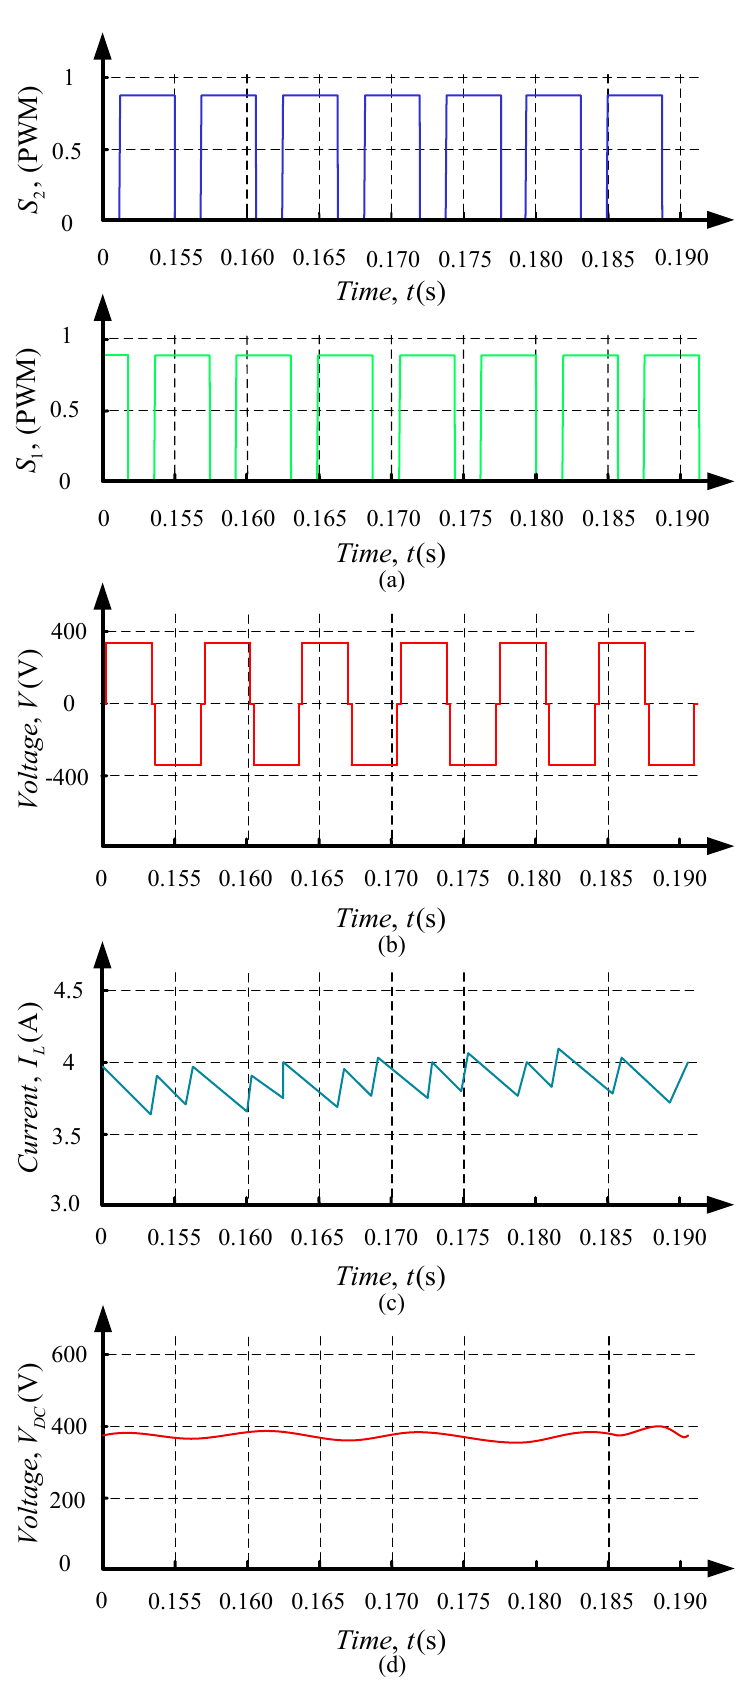
Figure 13. Output: ( a ) Fuzzy logic PWM; ( b ) transformer output; ( c ) inductor current; ( d ) DC output voltage.